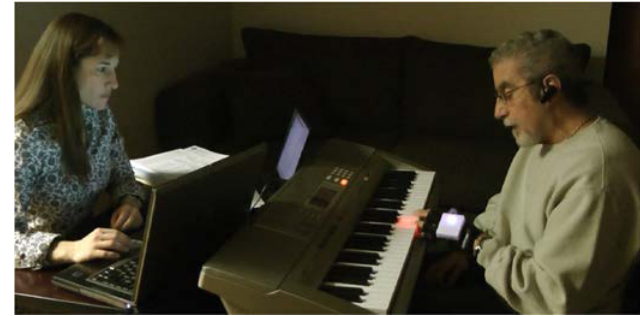
Fig. 5. Participant during an active practice